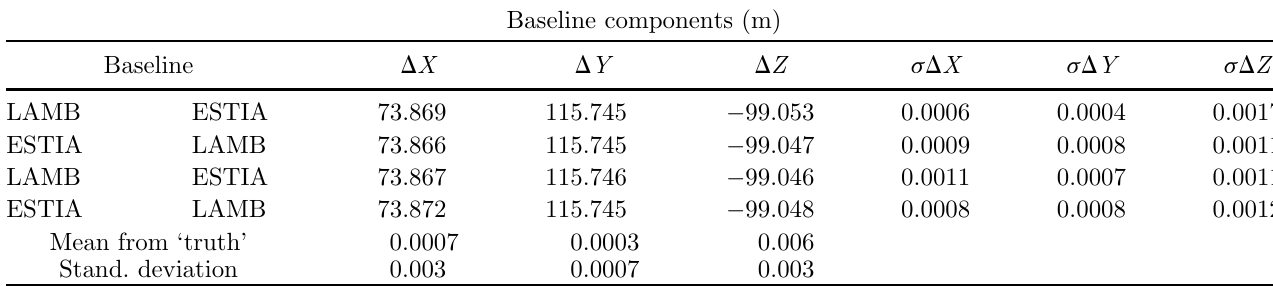
Table 5a. Baseline repeatability (low-cost